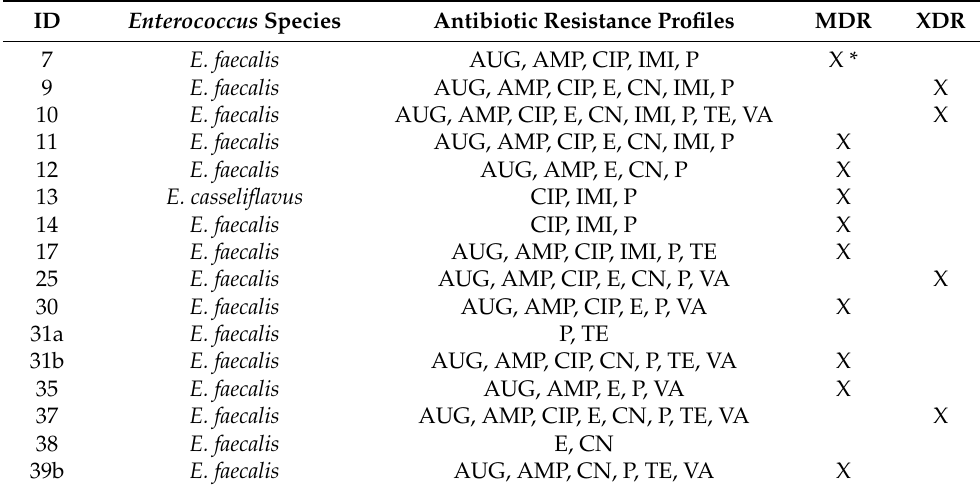
Figure 3. Antibiotic resistance profiles of Enterococcus spp. strains isolate from wild boars. Antibiotics: AUG: amoxicillin-clavulanate; AMP: ampicillin; CIP: ciprofloxacin; E: erythromycin; CN: gentamicin; IMI: imipenem; P: penicillin; SXT: sulfamethoxazole-trimethoprim; TE: tetracy-cline; VA: vancomycin. Table 3. Phenotypic antibiotic resistance profiles of collected Enterococcus spp. strains.